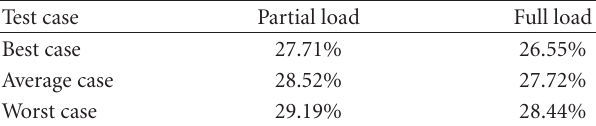
Figure 5: Simulations of the wind turbine benchmark working at partial load. Table 5: Monte-Carlo analysis with the sliding mode controller.